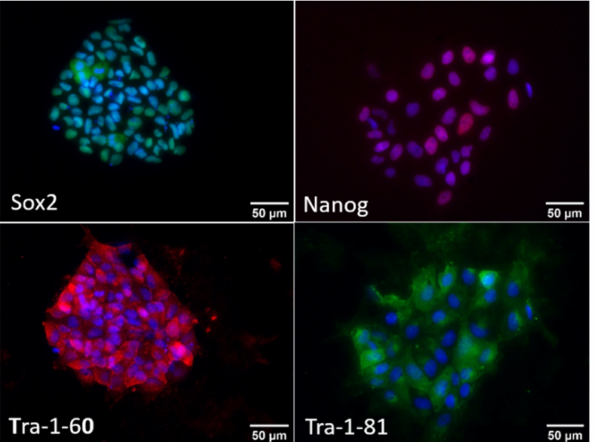
Figure 1. Characterisation of iPSCs. Representative immunofluorescence images of human iPSCs stained for the pluripotent markers Sox2 (green, ( upper panel )), Nanog (red, ( upper panel )), Tra-1-60 (red, ( lower panel )) and Tra-1-81 (green, ( lower panel )). Cell nuclei were stained with Hoechst (blue). Images were acquired at 400 ×